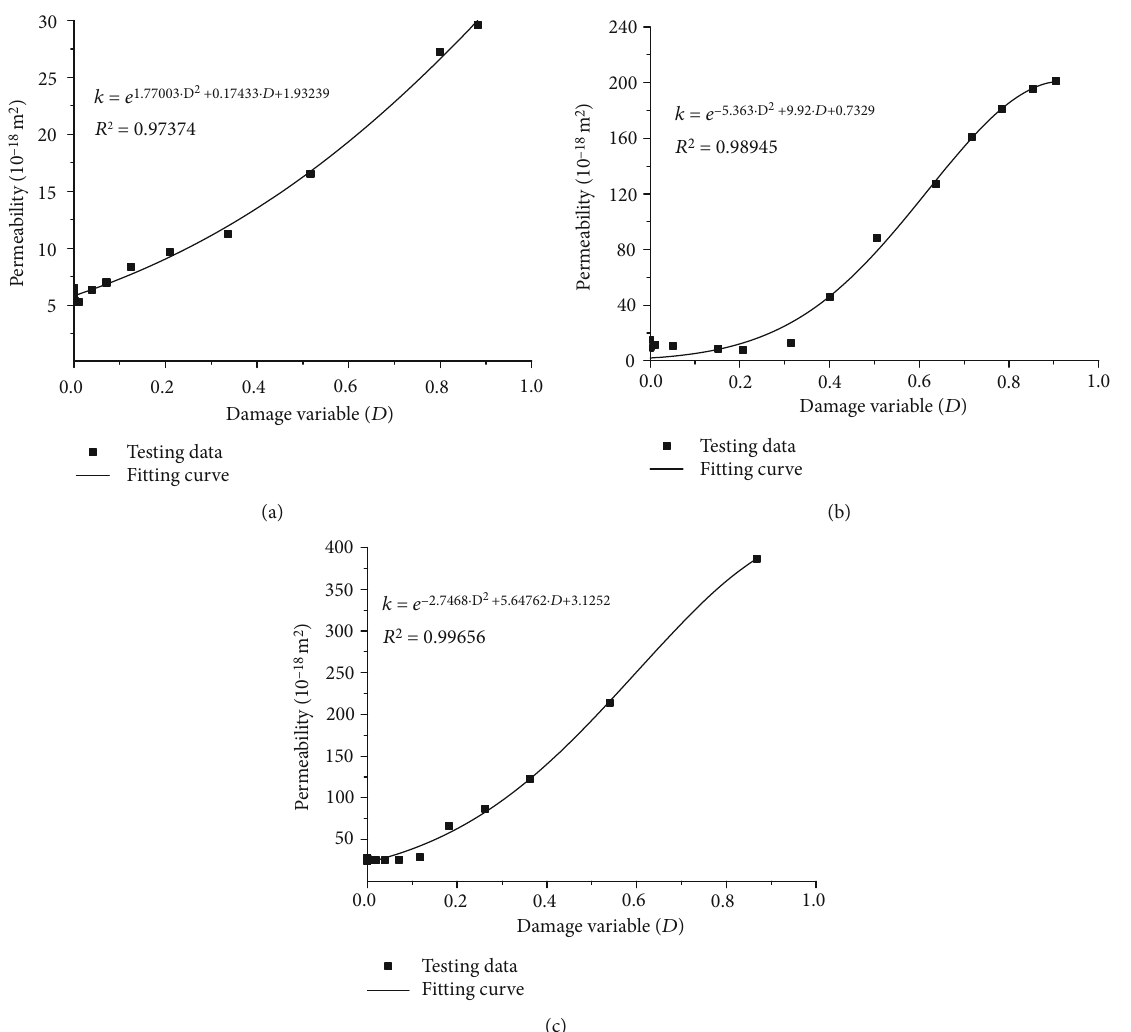
Figure 5: The relationship of the permeability and damage variation considering hydrated days. The labels in Fig.5 are as follows,(a) 2 days (b) 5 days (c) 10